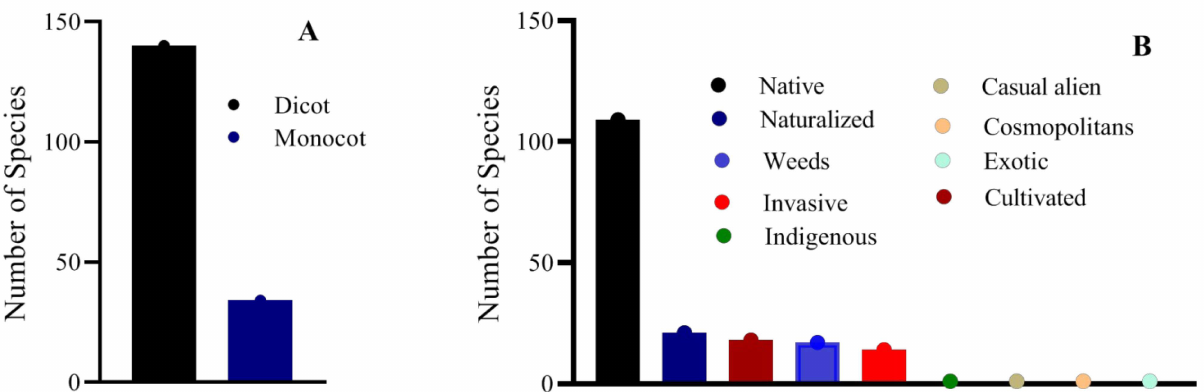
Figure 4. Spectrum based ( A ) on seed and status in Pakistan ( B ) of the flora recorded in the mining and non-mining sites along the River Panjkora